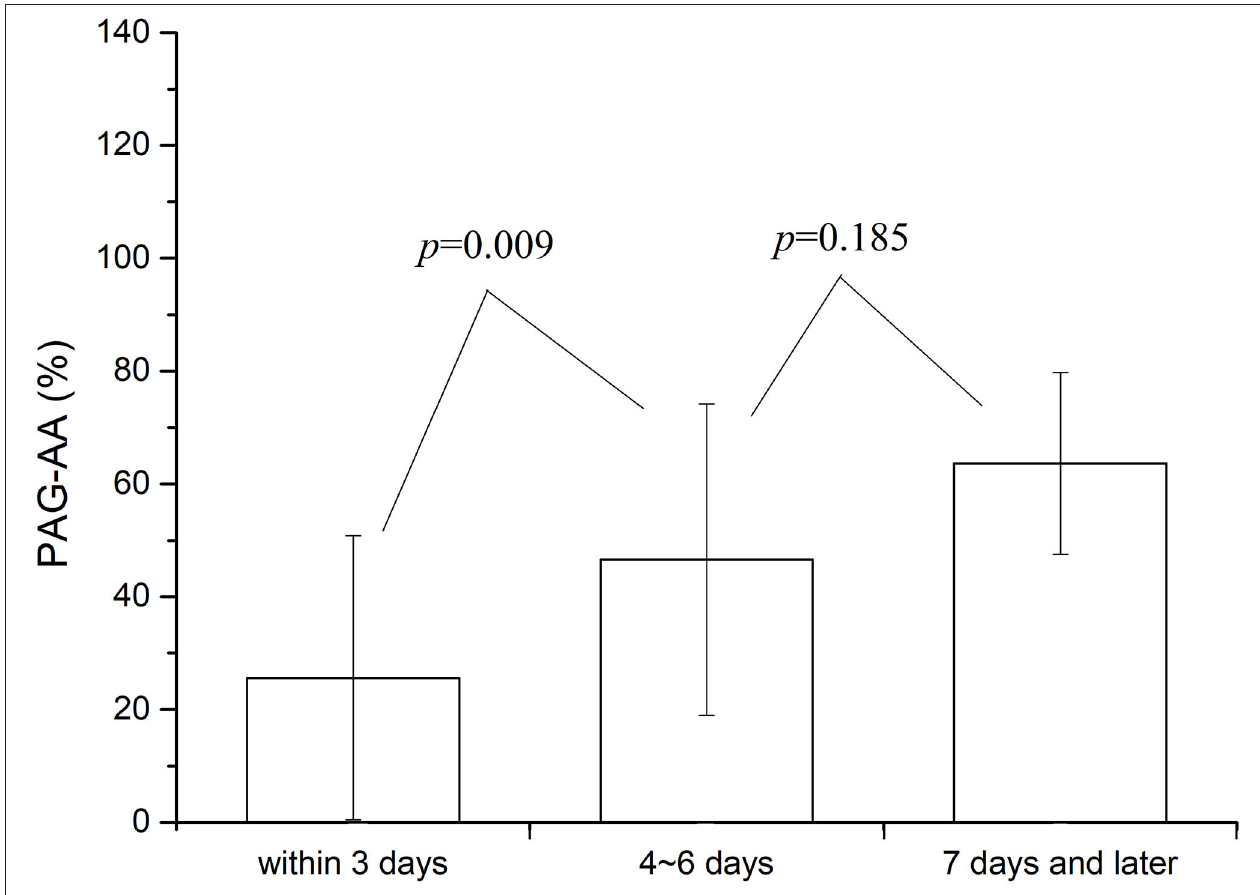
FIGURE 2 | Comparison of basal PAG-AA at different test time